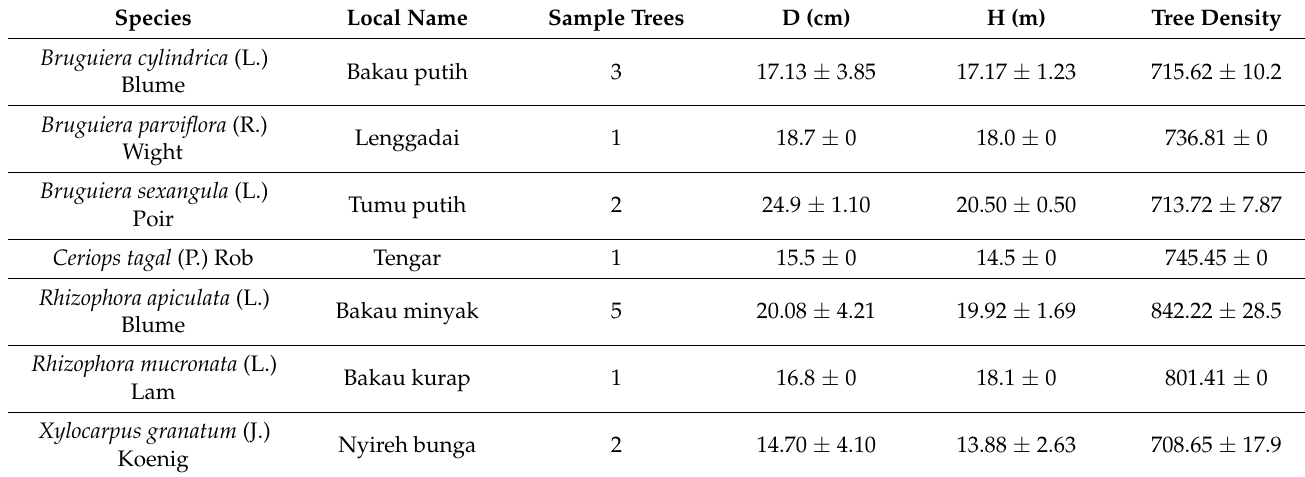
species (Table 1) based on the normal distribution of diameter at breast height, stem height (Figure A1 in Appendix B), and species composition. Table 1. The number of sampled tree species and range of the diameter and